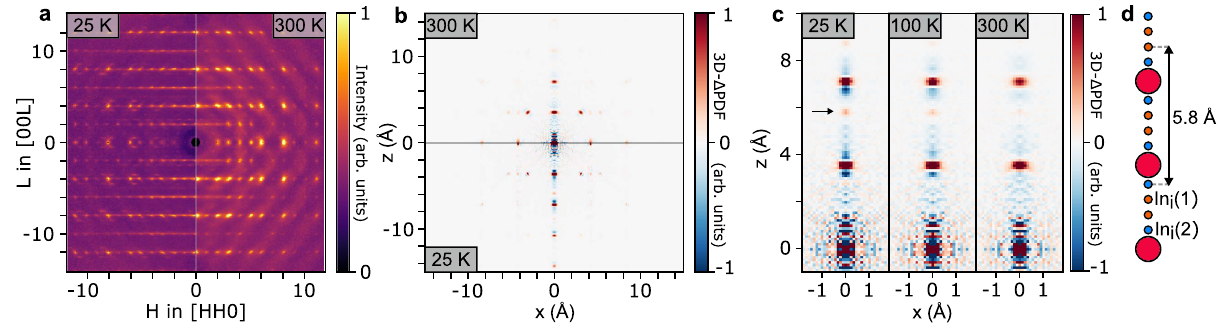
Fig. 4 Local ordering in 1D In 1 + chains. a Measured diffuse X-ray scattering in the HHL plane at 25 and 300 K. b 3D- Δ PDF in the x 0 z plane at 25 and 300 K. c Zoom on features in the 3D- Δ PDF along z at 25, 100 and 300 K. d Illustration of the 1D chain with the characteristic distance between interstitial sites marked, corresponding to the positive peak marked in ( c ) by a black